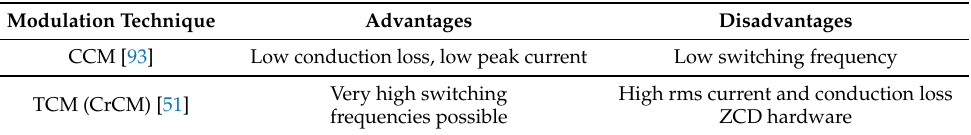
Table 7. Comparison of PFC modulation